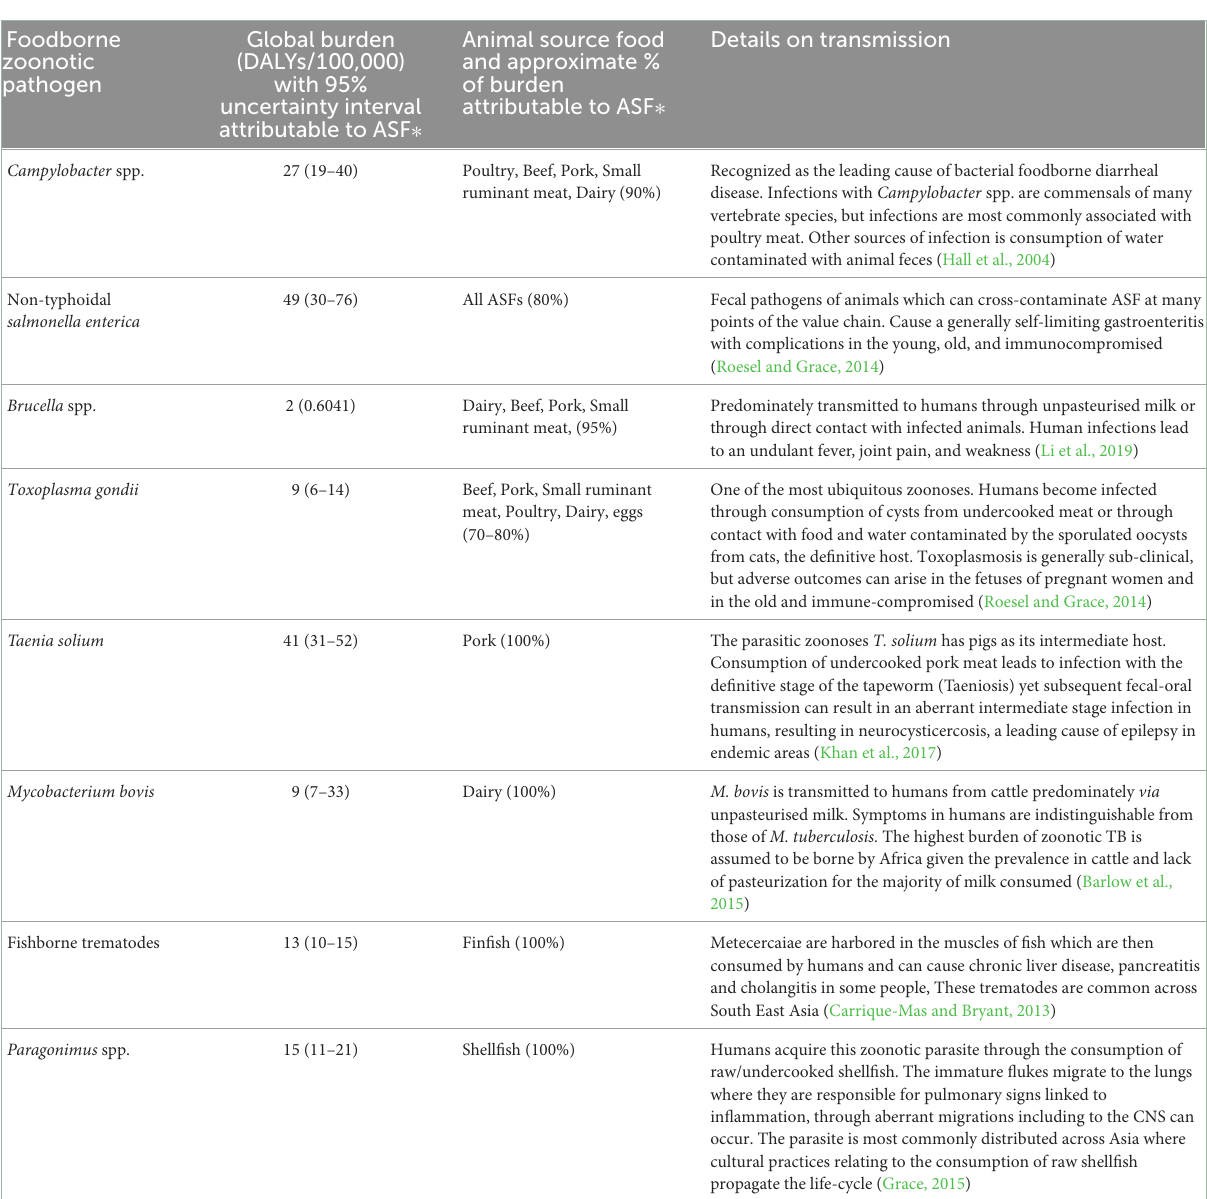
TABLE 1 Key foodborne zoonoses of particular relevance to LMICs in Africa and